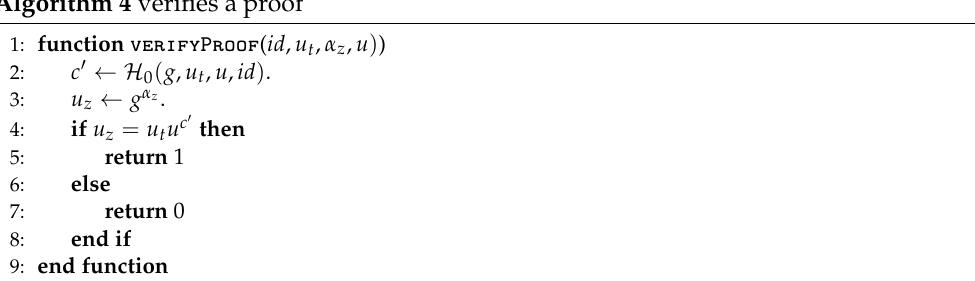
Algorithm 4 verifies a